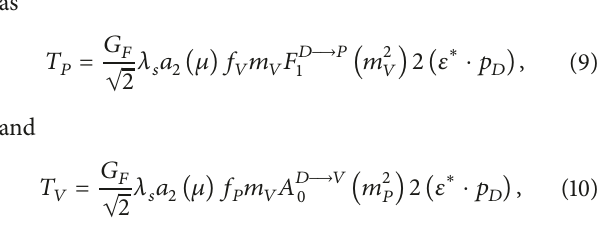
Figure 1: The relevant topological diagrams for 𝐷 󳨀→ 𝑃𝑉 with (a) the color-favored tree amplitude 𝑇 𝑃(𝑉) , (b) the 𝑊 -exchange amplitude 𝐸 𝑃(𝑉) , (c) the color-favored penguin amplitude penguin amplitude 𝑃𝐴 𝑃(𝑉)